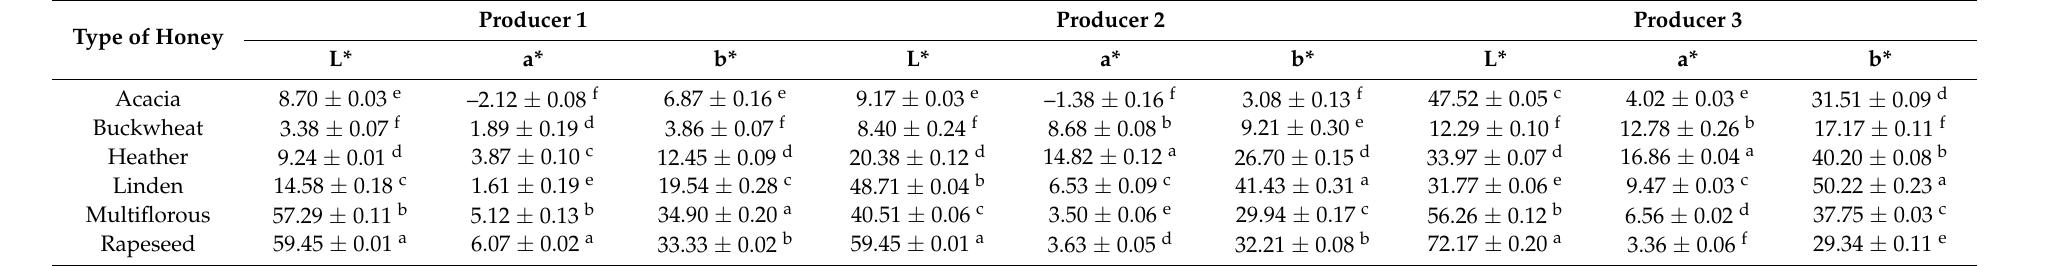
Table 1. Color measurement in different types of honey using the CIELAB